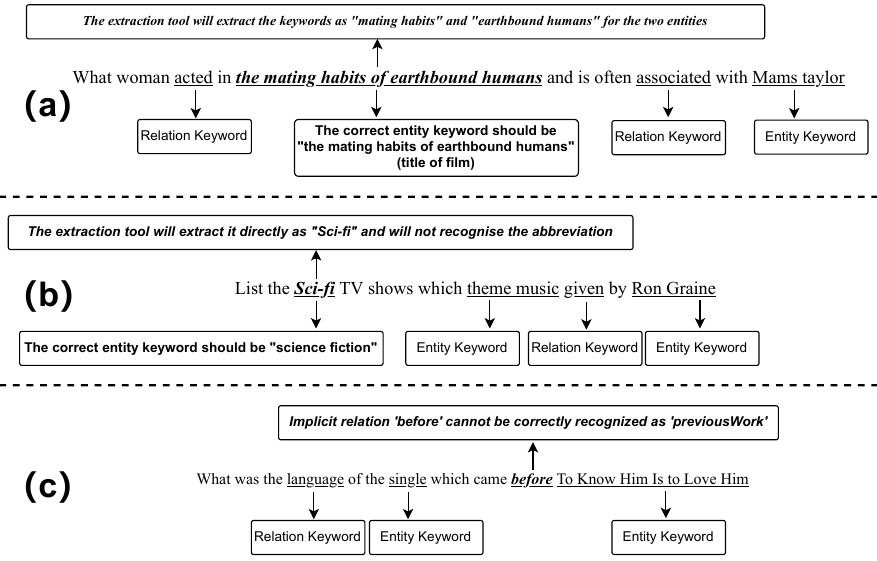
Figure 1. The issues addressed in this paper. ( a ) The number of words in the question for the entity keyword is high and existing keyword-extraction tools may split the complete entity keyword into multiple; ( b ) Existing keyword-extraction tools cannot accurately hit the correct entity keyword when it appears in the question in its abbreviated form; ( c ) When the issue relation is complex, the keyword-extraction tool may not be able to hit the correct relation candidates accurately. These three types of problems result in the inability to select the correct entity/relation candidate, thus affecting the correctness of the entity/relation